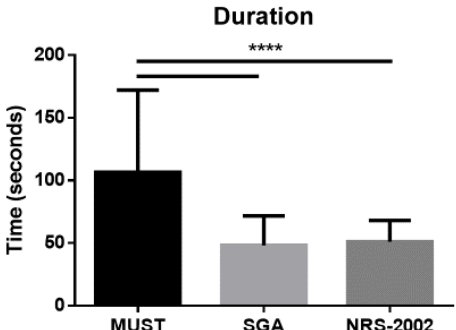
Figure 2. Duration of the nutritional screening tools (time expressed in seconds), performed in all the 152 hospitalized patients enrolled in this study. Data are expressed as mean ± SD. Statistical di ff erences were assessed by one-way ANOVA and Tukey as post hoc test. MUST, Malnutrition Universal Screening Tool; SGA, Subjective Global Assessment; NRS-2002, Nutritional Risk Screening 2002. ****: p < 0.0001 vs. MUST.